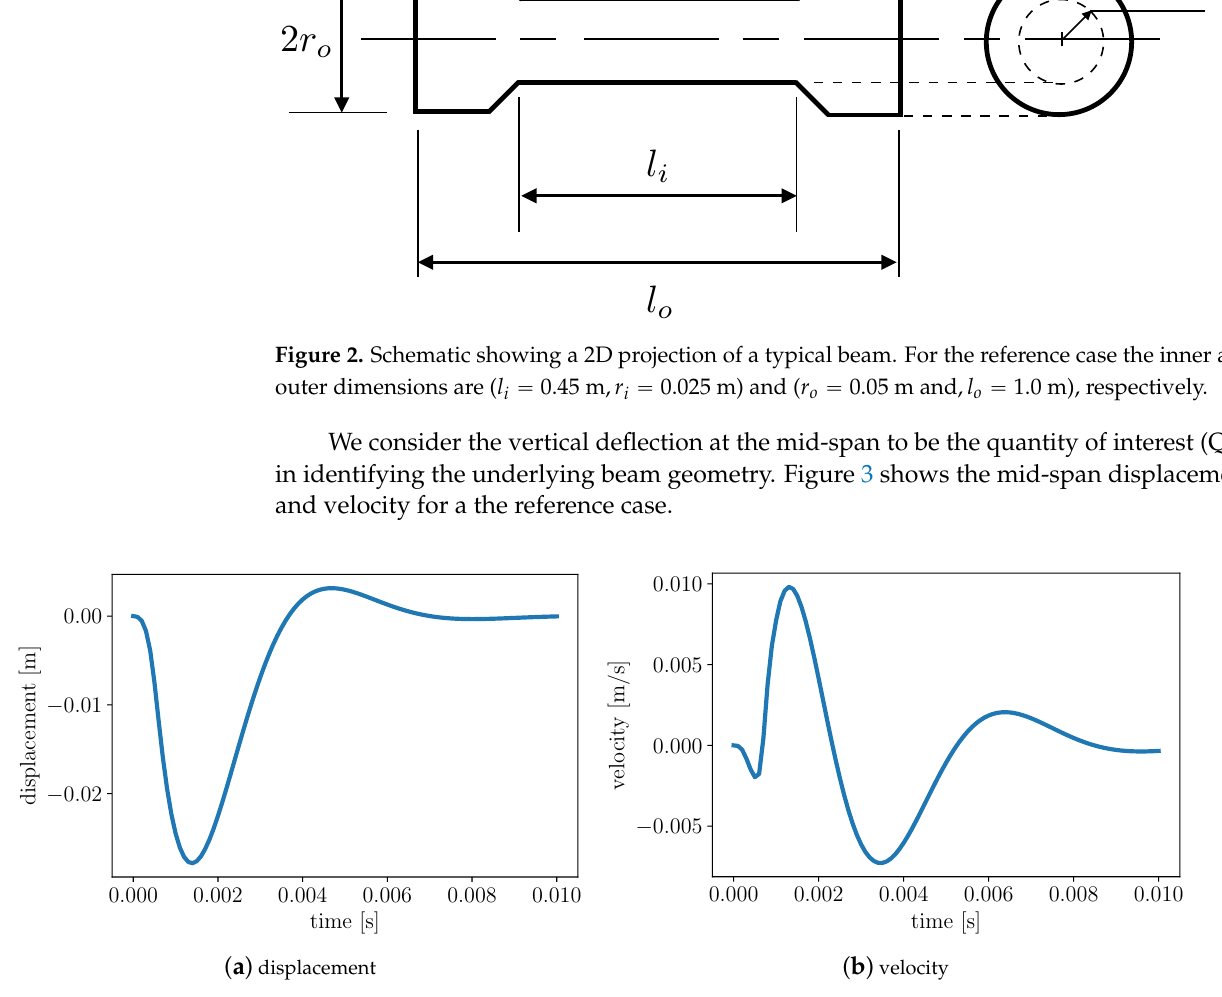
Figure 3. The displacement and velocity at the mid-span of the reference case for the mean material properties E “ 70 GPa, ν “ 0.3 and ρ “ 26.25 kN/m 3